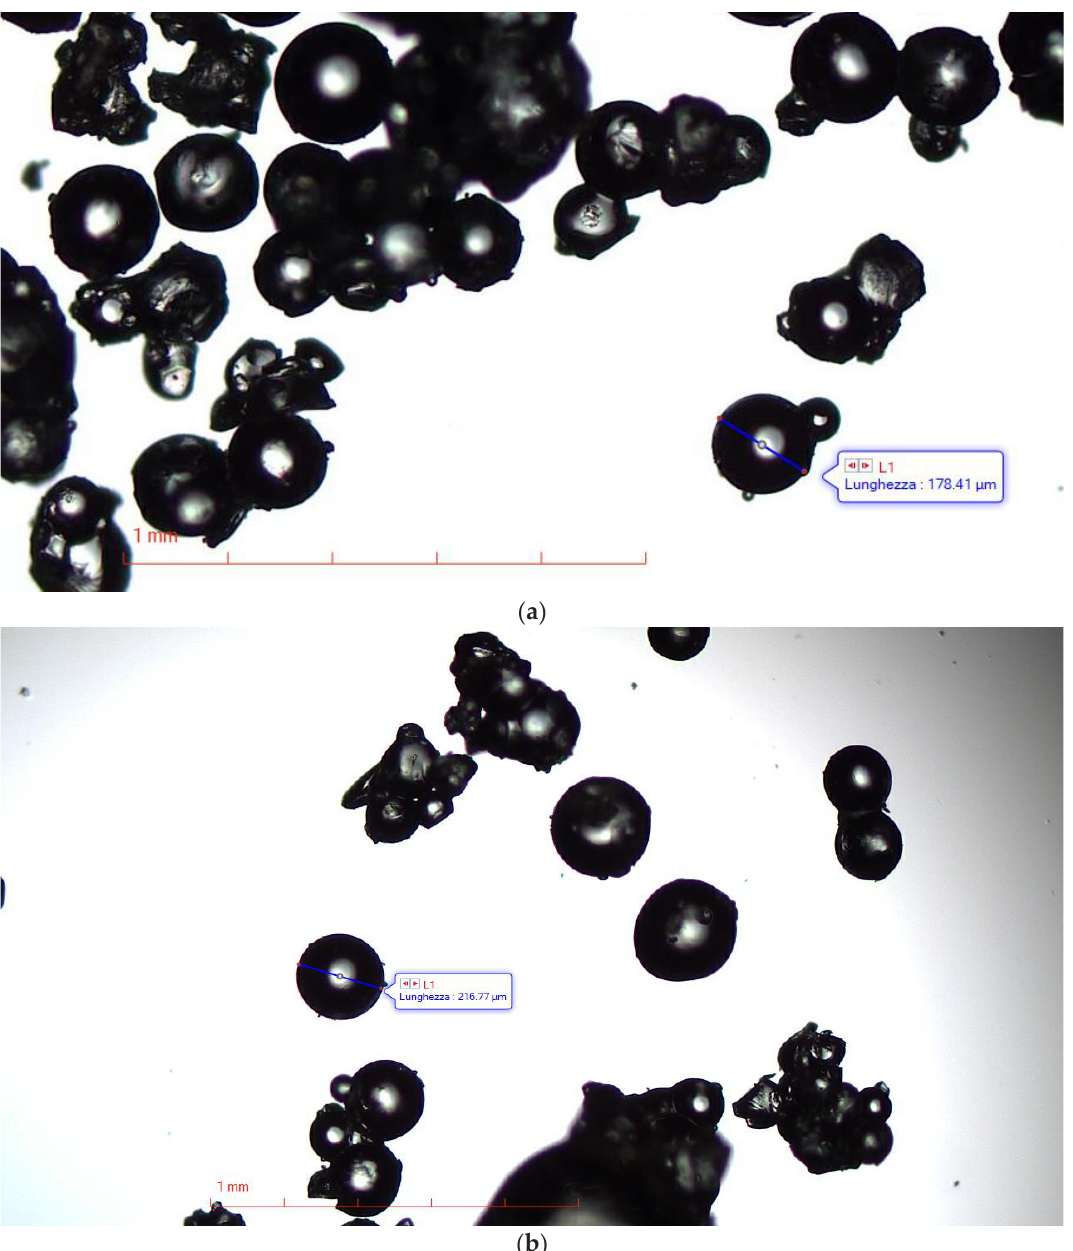
Figure 3 . Optic images (obtained using a 4 × objective) of R1 showing microdimensioned particles of 178 µm ( a ) and 217 µm ( b ).